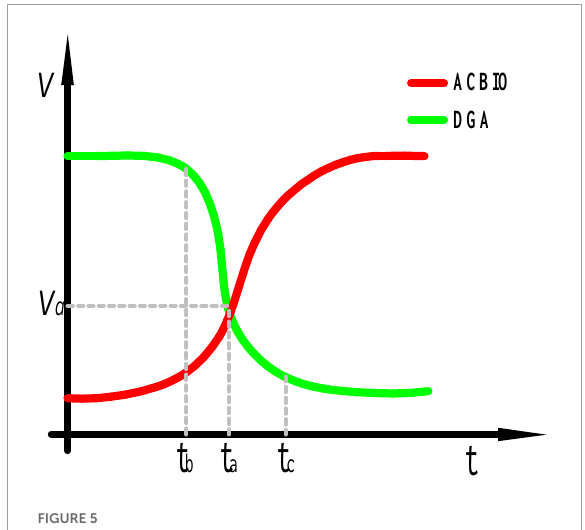
FIGURE5 Search speeds of the dynamic genetic algorithm (DGA) and ant colony binary iterative algorithm (ACBIO).